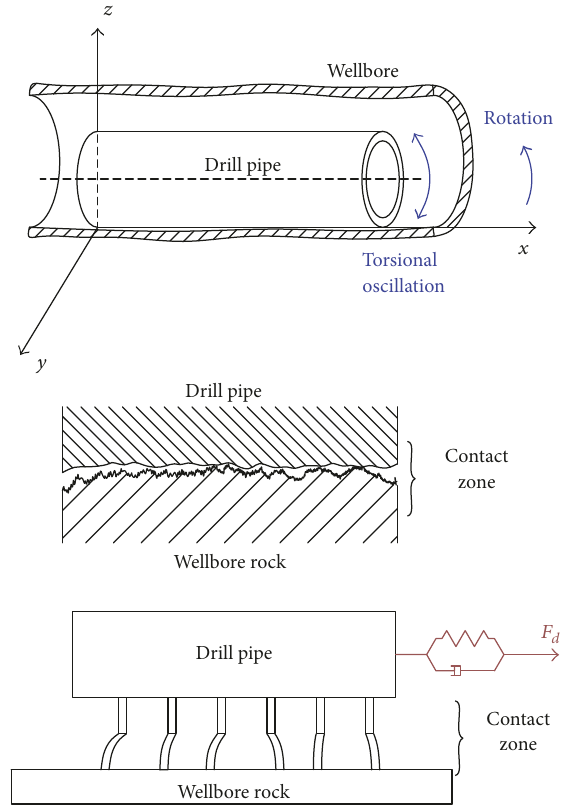
Figure 2: Modeling of contact’s elastic